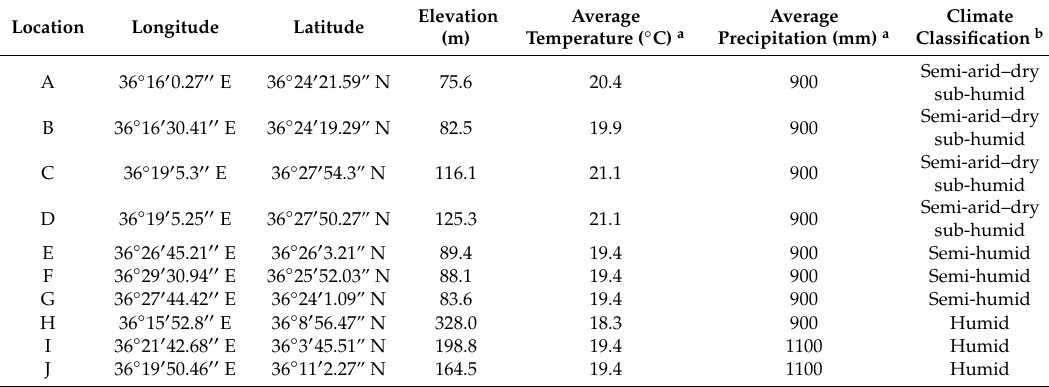
Table 3. Geographical and meteorological data of the collection